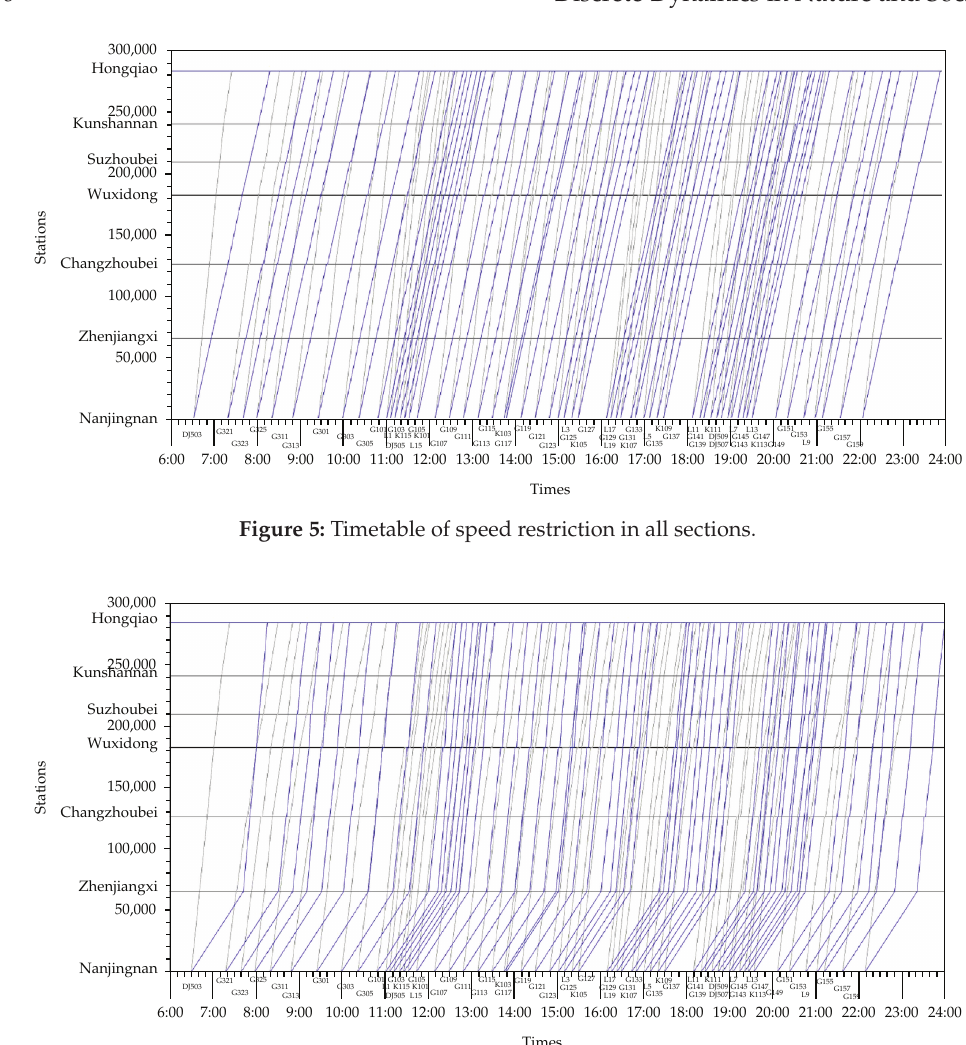
Figure 6: Timetable of speed restriction in first